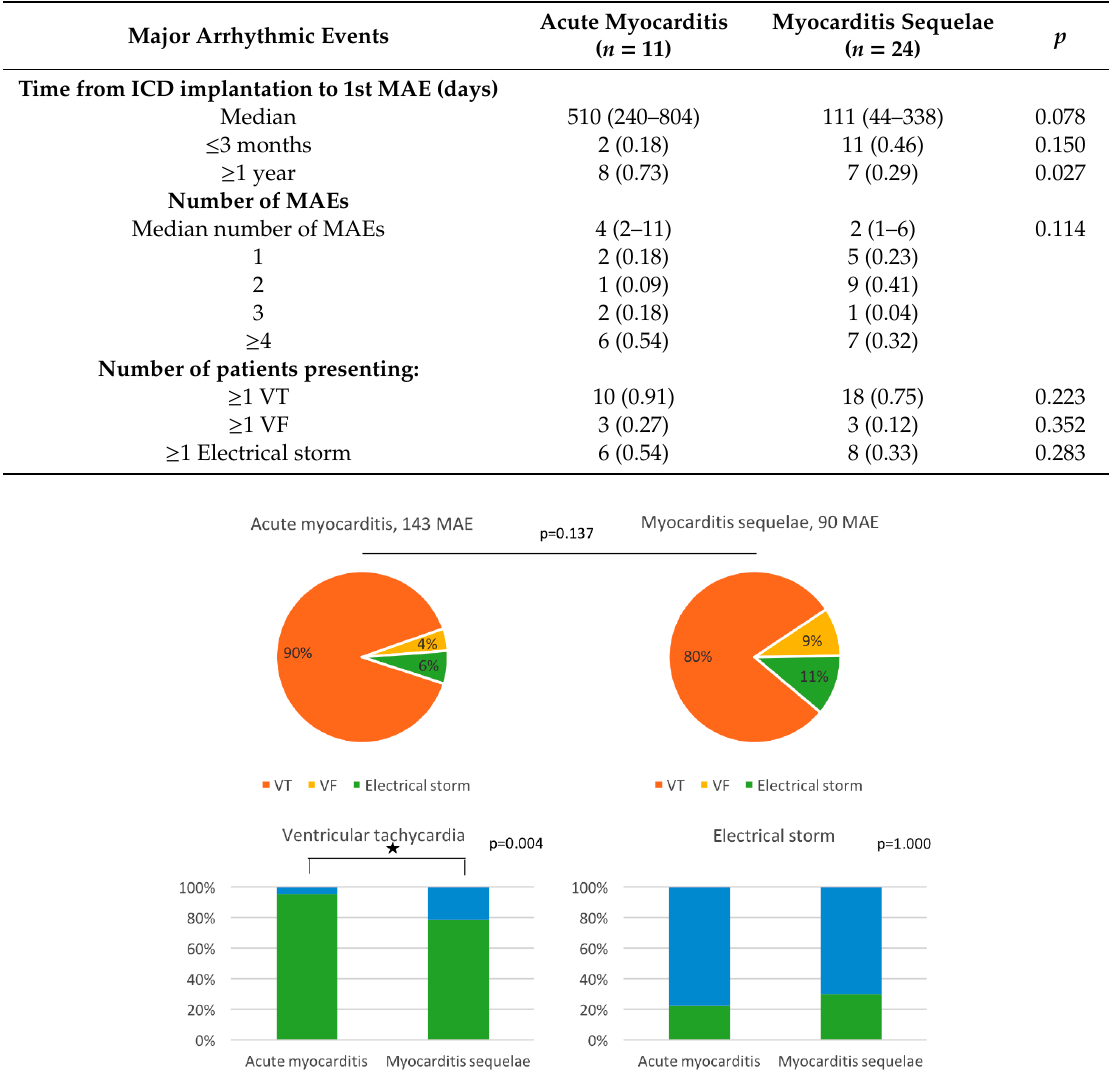
Table 6. Description of major arrhythmic events (MAEs). ICD: implantable cardioverter defibrillator, VT: ventricular tachycardia, VF: ventricular fibrillation.